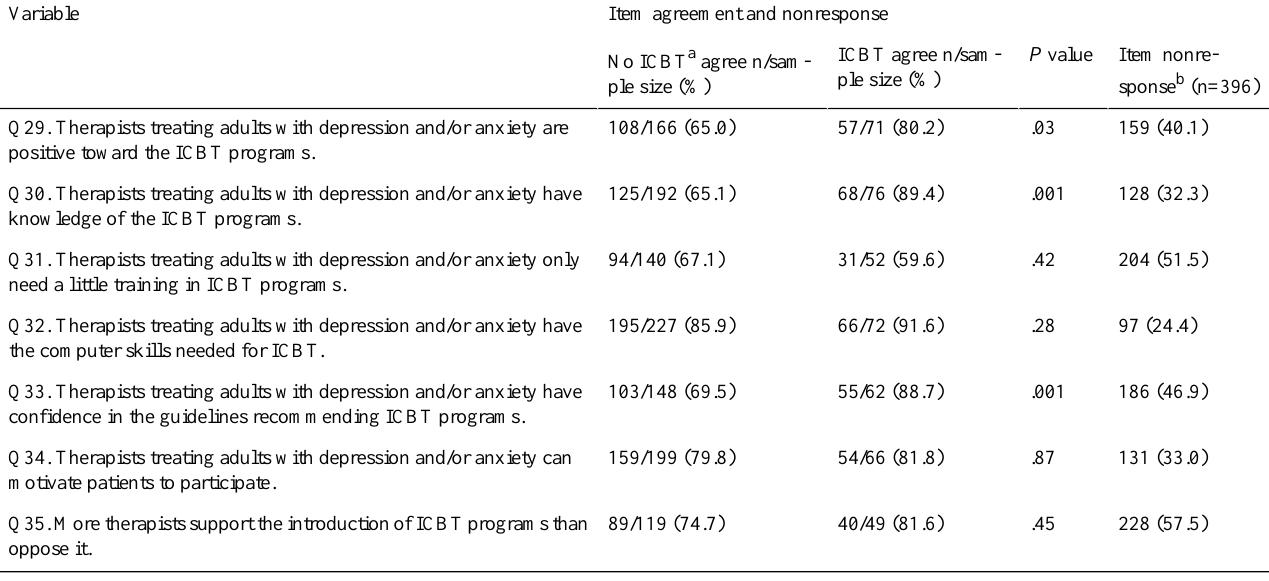
Table 3. Implementers and nonimplementers agreeing to therapist-related items.